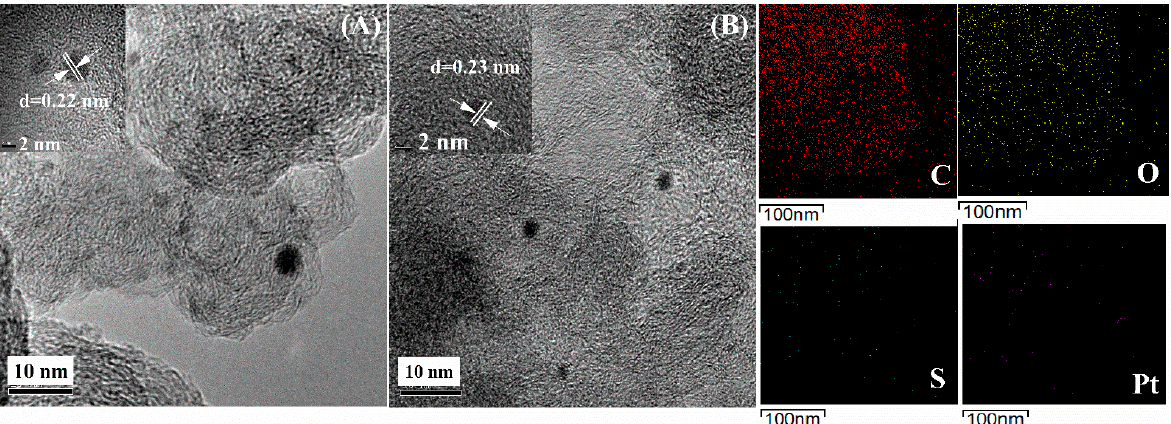
Figure 4. ( A ) TEM and HRTEM images of Pt/PTC; ( B ) TEM and HRTEM images of Pt/PTC-S, the element mapping images of C, O, S, and Pt in